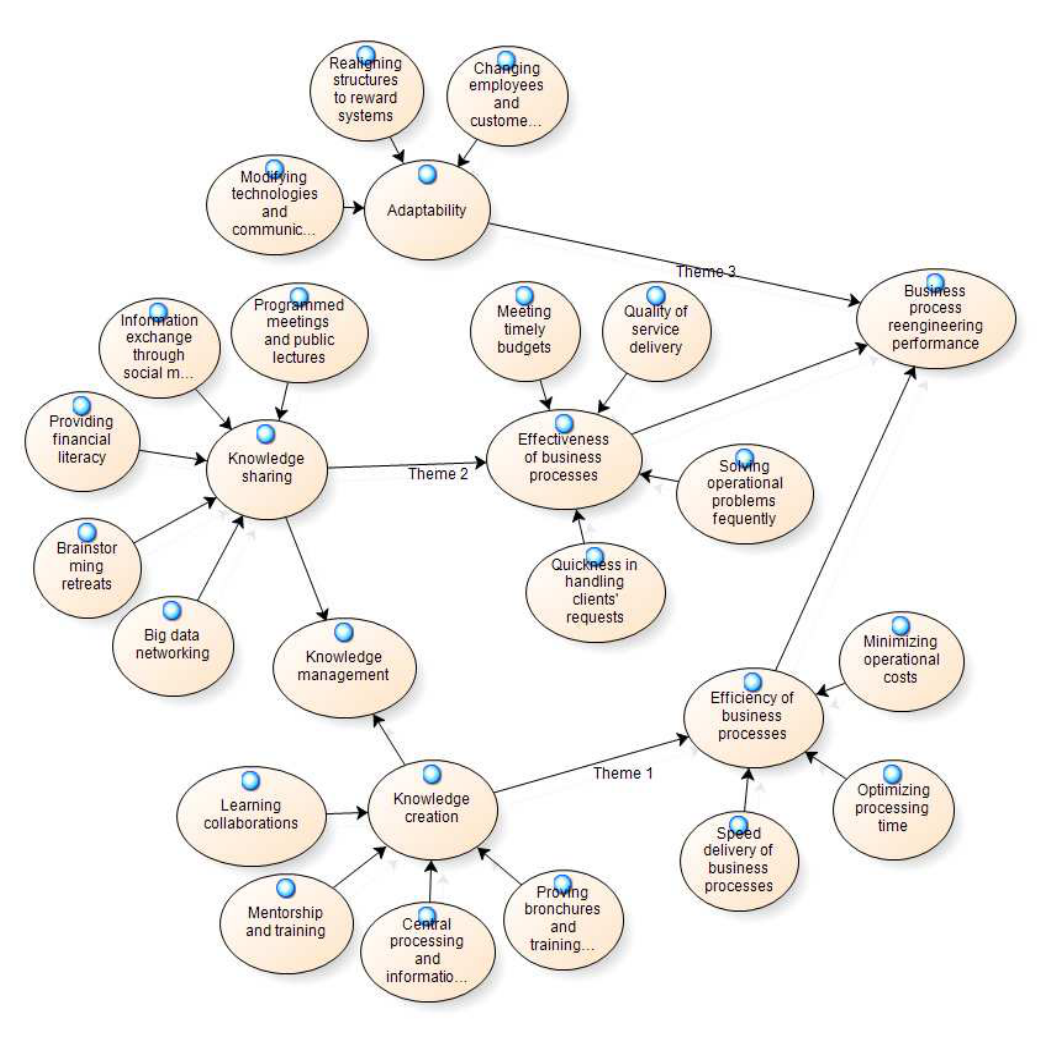
Figure 1A. Qualitative data